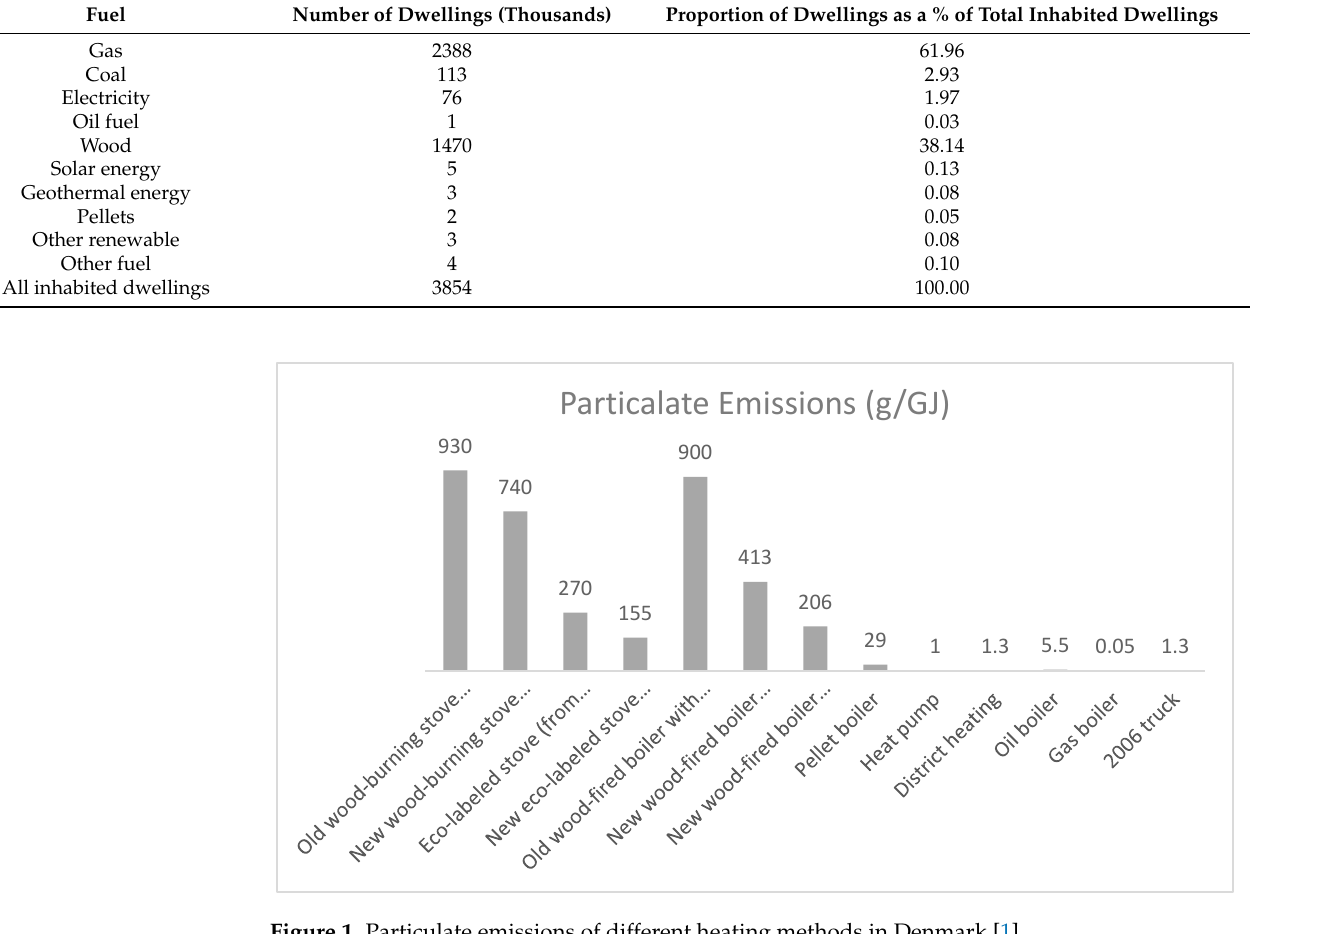
Table 1. Use of fuel in inhabited dwellings in Hungary (2011) .